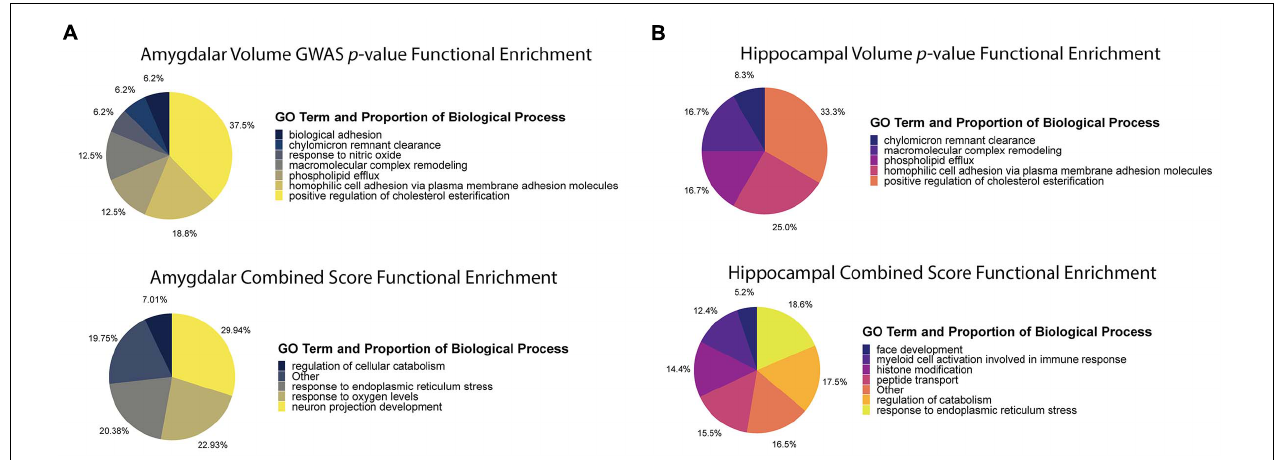
FIGURE 5 | Functional enrichment analysis using p -value and combined score. (A) Functional enrichment analysis of amygdala volume GWAS p -value ranking and combined score rankings. The p -value functional enrichment analysis revealed terms like biological cell adhesion and macromolecular complex remodeling. By comparison, the functional enrichment analysis for the combined score revealed terms relating to ER stress, neuron projection development, and response to oxygen levels which are all pathways affected by AD pathophysiology. (B) Functional enrichment analysis of hippocampal volume GWAS p -value ranking and combined score rankings. The p -value functional enrichment analysis saw similar enrichments as the amygdala p -value functional enrichment analysis. The combined score functional enrichment analysis on the other hand, saw enrichment of pathways involved in development, ER stress, and immune response